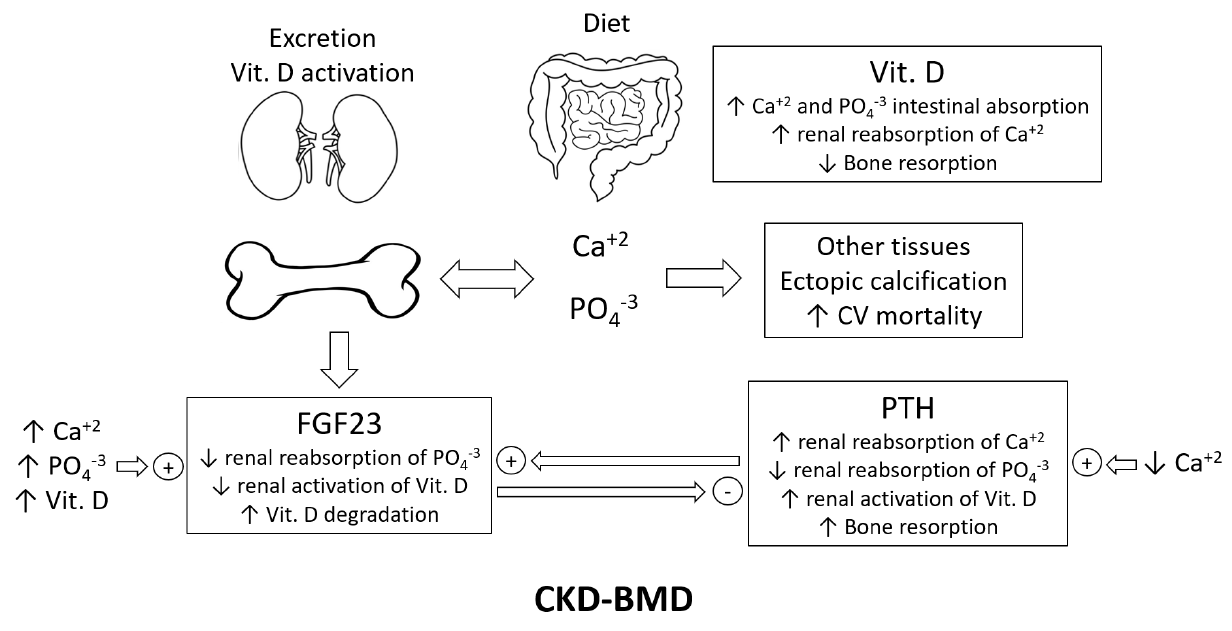
Figure 1. Key players in CKD-BMD; Vit. D = vitamin D; CV = cardiovascular; FGF23 = fibroblast growth factor 23; and PTH = parathyroid hormone.